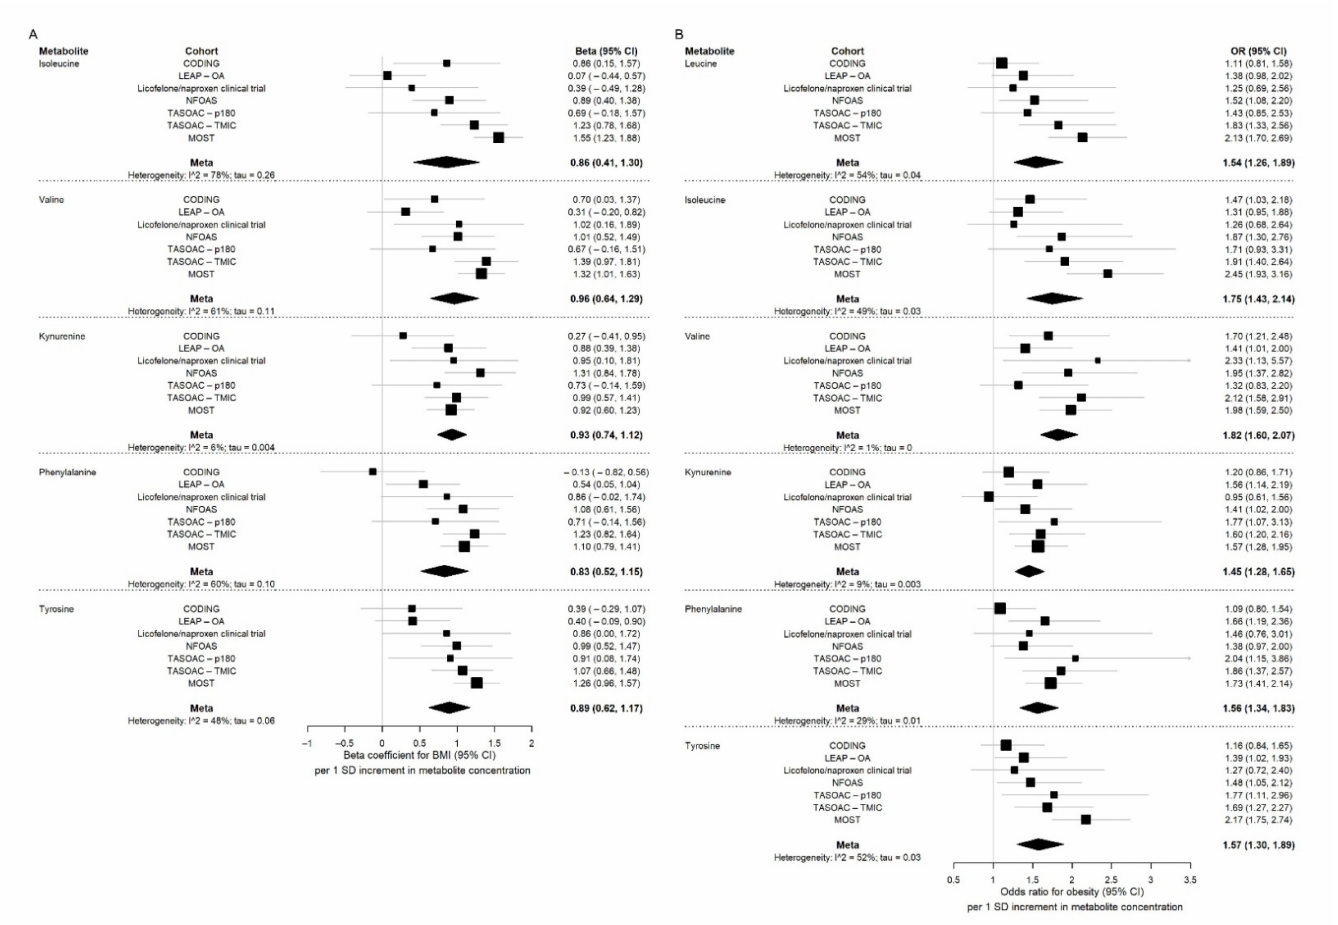
Figure 2. Forest plots for major amino acids associated with BMI or obesity. ( A ) Forest plots for major amino acids associated with BMI; ( B ) forest plots for major amino acids associated with